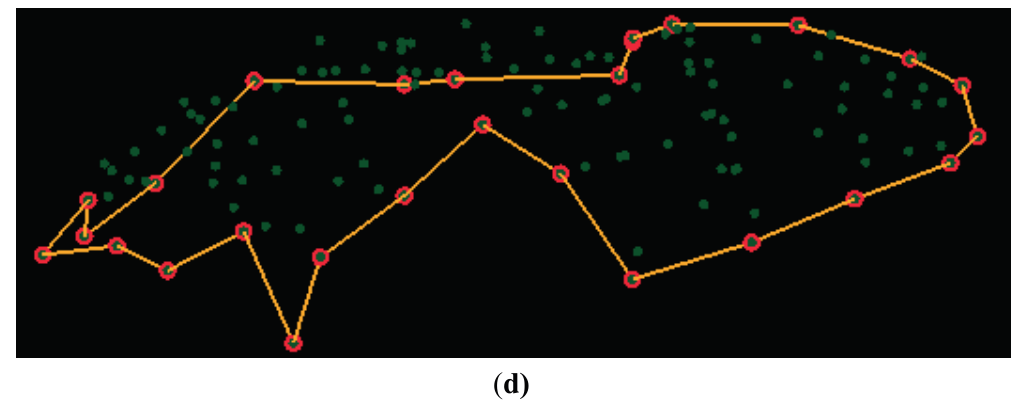
Figure 5. The extracted vehicle segments from the point cloud in Figure 3b by the rule-based classification (Note that each potential vehicle segment is drawn with a random color).